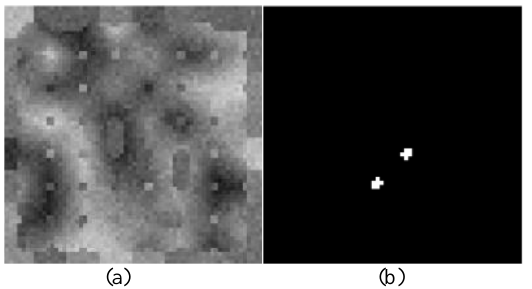
Figure 4. (a) First band of simulated data 2, (b) Groundtruth of targets.